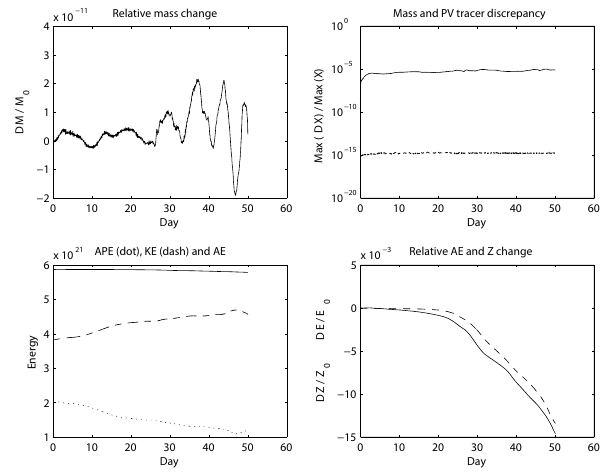
Figure 8. Diagnostics demonstrating the effects of the mimetic properties. Top left: relative change in total mass. Top right: maxi- mum relative discrepancy between advected dual grid tracer and di- agnosed dual grid φ (solid), and between advected dual grid tracer and diagnosed PV (dashed). Bottom left: available potential energy (dotted), kinetic energy (dashed), and total available energy (solid) all in m 6 s − 2 . Bottom right: relative change in total available energy (solid) and in potential enstrophy